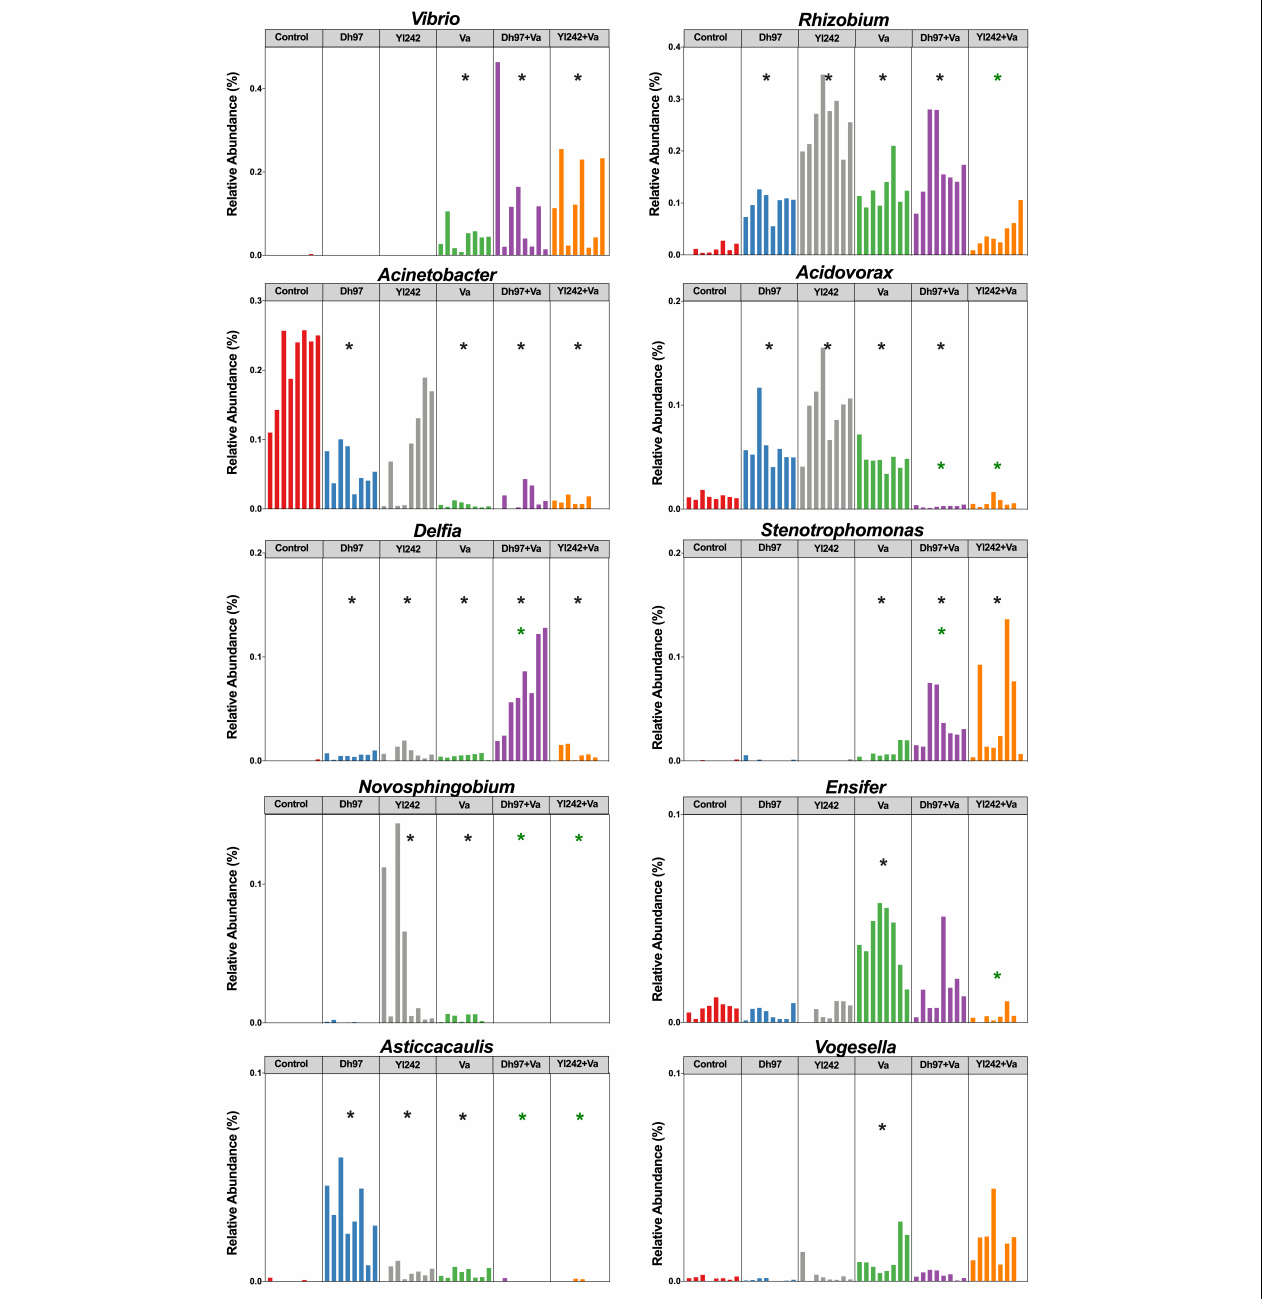
FIGURE 4 | Relative abundance of bacterial genera affected by infection with V. anguillarum . Analysis of the bacterial microbiota was performed in Tg(Bacmpx:GFP) i 114 zebrafish larvae at 8 days post fertilization (dpf), corresponding to 3 days post V. anguillarum infection. Control group: non-inoculated conventionally raised larvae (CONV-R). Dh97 and Yl242 groups: CONV-R larvae inoculated by immersion with 5 × 10 6 CFU/mL of D. hansenii 97 or Y. lipolytica 242, respectively, at 4 dpf. Va group: CONV-R larvae challenged at 5 dpf by immersion with 10 7 CFU/mL of V. anguillarum . Dh97 + Va and Yl242 + Va groups: CONV-R larvae inoculated by immersion with both yeasts at 4 dpf and challenged with V. anguillarum at 5 dpf. Significant differences between groups and the control group are marked with black asterisks. Green asterisks indicated significant differences between Dh97 + Va or Yl242 + Va with Va group ( p < 0.05, Kruskal–Wallis followed by Dunn’s